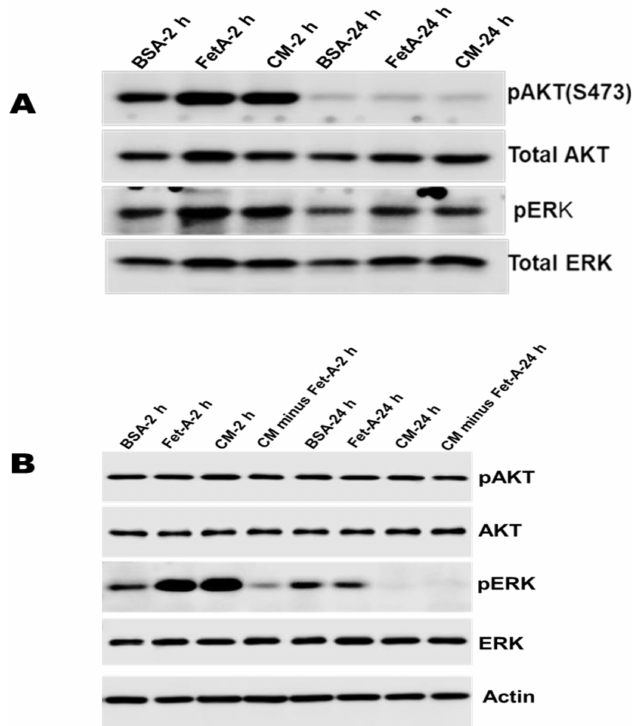
Figure 6. Distinct roles of fetuin-A on the activation of AKT and ERK in LNCaP cells growing in 2-D or 3-D. In ( A ), Cells growing in (2-D) culture flasks were serum-starved, and then the medium was changed to SFM containing BSA, Fetuin-A, or CM and incubated for the indicated time points, after which the cells were lysed in RIPA buffer and analyzed by Western blotting. As shown, activated AKT (pAKT) was slightly elevated in the presence of fetuin-A and CM compared to BSA, 2 h after serum starvation. However, after 24 h, pAKT had disappeared. Activated ERK, on the other hand, was evident for 24 h. In ( B ), the cells were grown in high attachment culture flasks until ~70% confluent. The cells were serum-starved, detached, and then re-plated in SFM containing BSA, fetuin-A, CM, and CM depleted (minus) of fetuin-A in ultra-low attachment flasks (3-D growth) and incubated for the indicated periods, after which the cells were lysed in RIPA buffer and analyzed by Western blotting. Of note was the high activation of ERK (pERK) in the presence of fetuin-A and CM, 2 h after serum starvation. Interestingly the activation was not observed in CM depleted of fetuin-A, with the implication that fetuin-A was responsible for ERK activation. After 24 h, ERK was still activated in the presence of fetuin-A but not CM. However, AKT was activated for the entire 24 h after serum starvation in the presence of BSA, fetuin-A, CM, as well as CM depleted of fetuin-A. In 3-D growth, AKT remained activated over a 24 h period following serum